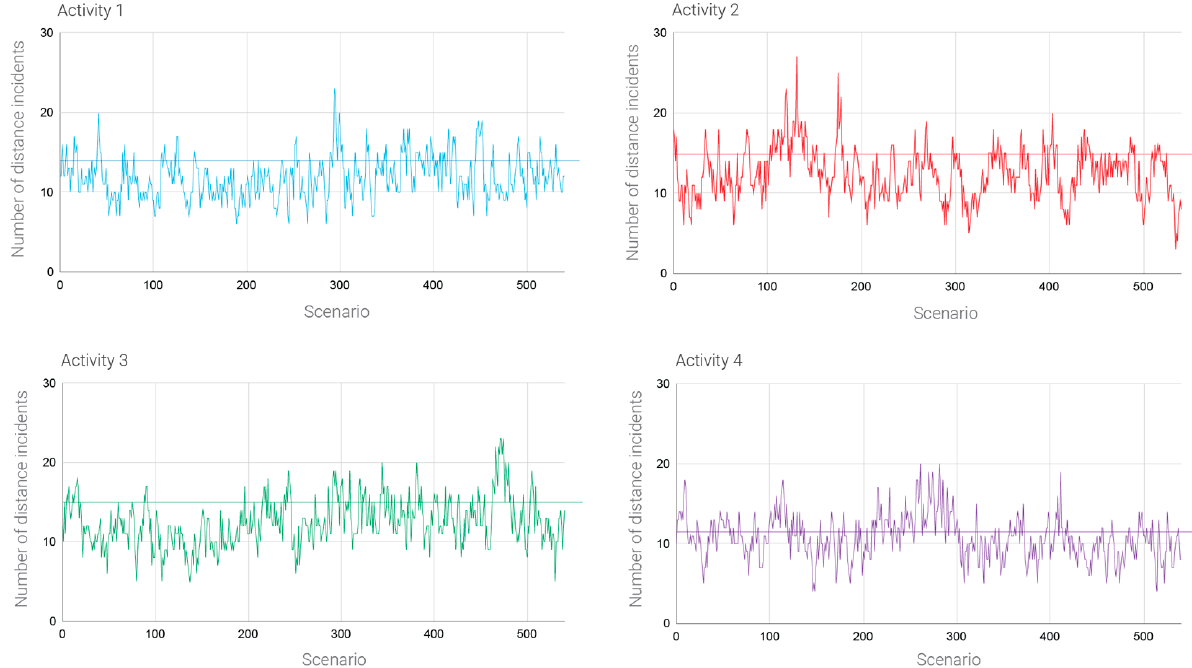
Figure 7. Distribution of distancing incidents for four furniture layouts corresponding to different teaching and learning activities, without contact time consideration.